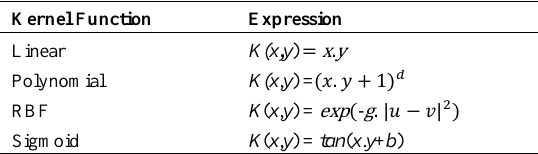
Table 3. The Types of